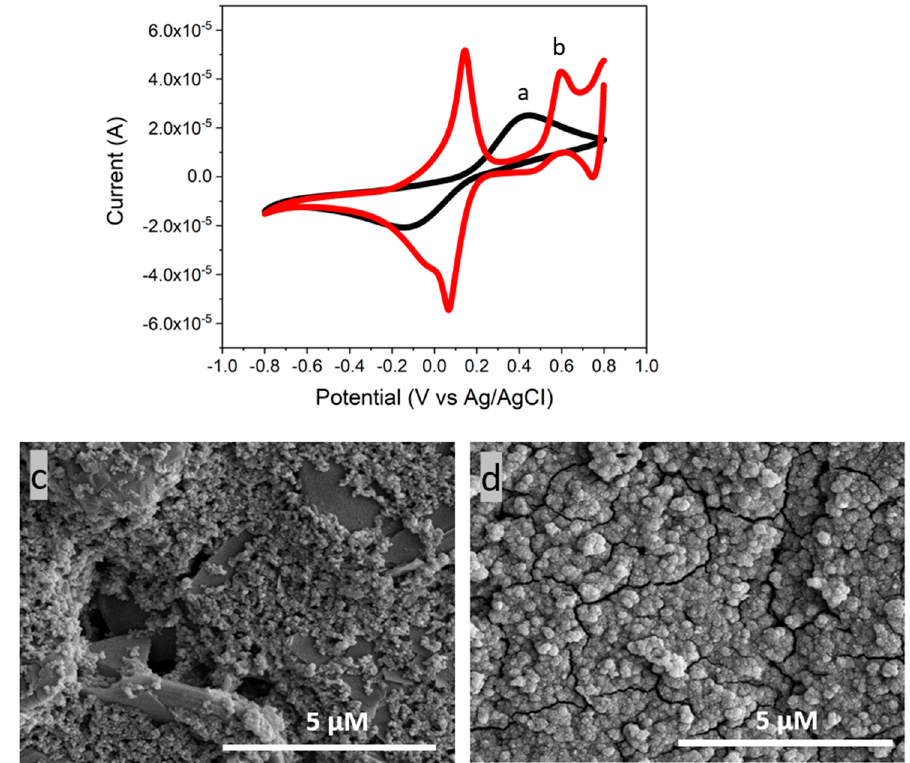
Figure 4. CV results of ( a ) a bare screen printed carbon electrode (GCE), and ( b ) PB deposited on a GCE in a 0.1 M phosphate buffer solution (PBS, pH7.2) containing 5 mM of [Fe(CN) 6 ] 3 − /4 − and 0.1 M KCl with 100 mV/s of scan rate. SEM images of ( c ) a bare GCE and ( d ) PB deposited on a GCE.